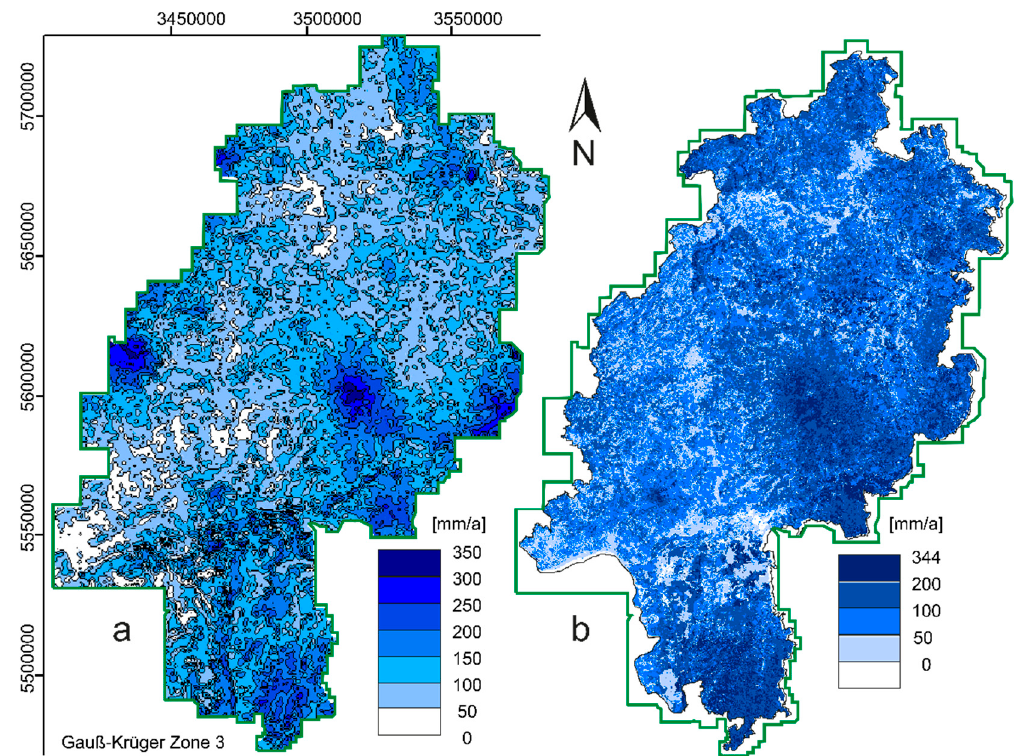
Figure A3. Recharge data for the Federal State of Hesse from ( a ) Neumann et al., [56] and ( b ) Kopp et al. [54].